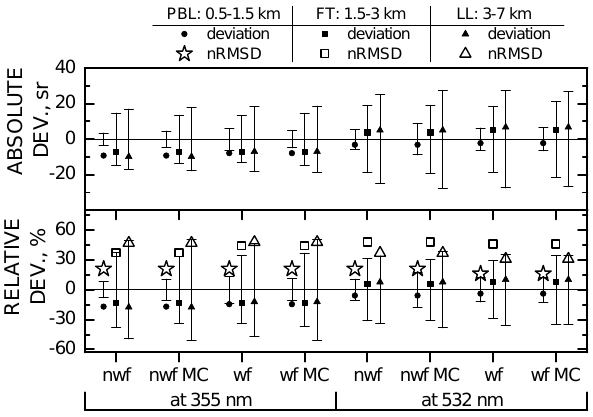
Figure 15. Same as Fig. 11, but for particle lidar ratio